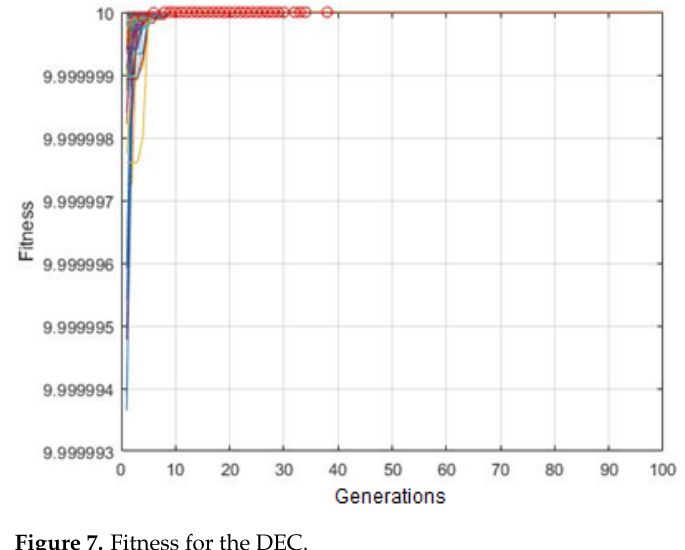
Figure 7. Fitness for the DEC. Figure 8. Average generation convergence for DEC.